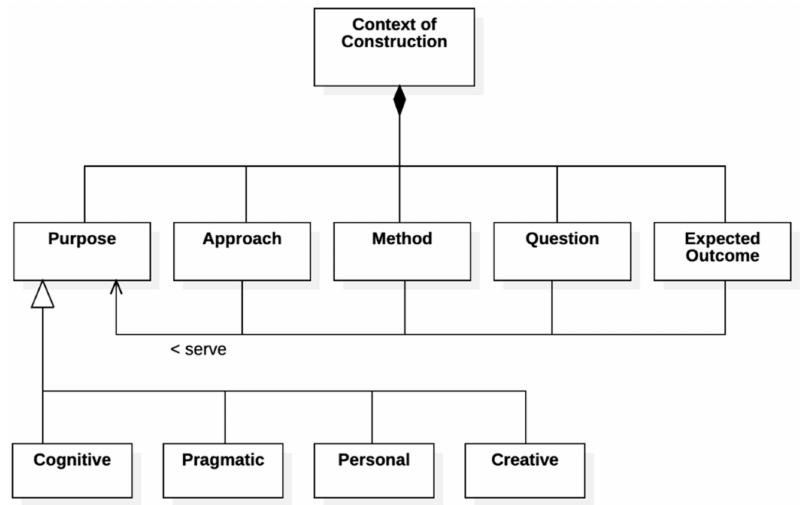
Figure 1. Context of Construction. The Context of Construction consists of the Purpose for which a construction is undertaken; the Approach that guides the process; the Method(s) used to obtain or produce the desired information; the Question(s) to be answered; and the Expected Outcome, which includes at least the Constructed Past. The other four components of Context of Construction